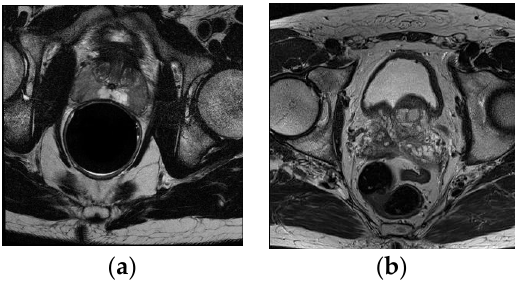
Figure 2. Example image slices from ASPS13 dataset. ( a ) 1.5T with ERC from BMC; ( b ) 3.0T with SC from RUNMC.